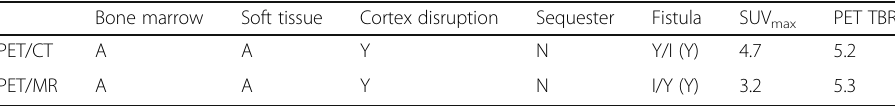
Table 1 Consensus results for patient